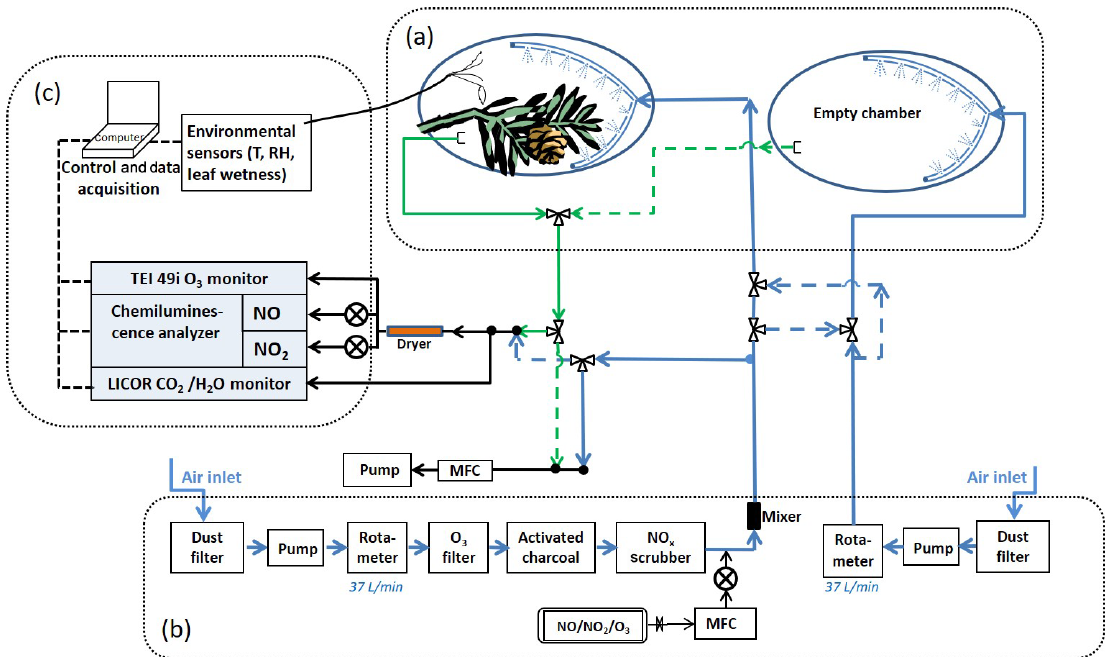
Figure 2. Schematic of the enclosure experiment system. The system is comprised of three main parts as shown in the figure: (a) the enclosures, (b) the purge air flow system, and (c) the trace gas measurement instruments. The blue lines and arrows indicate the air flowing into the enclosures; the green lines and arrows indicate the air flowing out of the enclosures; and the black lines and arrows indicate the air sample flow and the balance flow (to maintain constant flow rates in the enclosures). NO and NO 2 gas standards were used for the controlled addition of these trace gases to the input air stream. Controlled O 3 addition was done by generating ozone on demand using a Pen-Ray UV lamp and ultra-high purity oxygen. See text for instrument